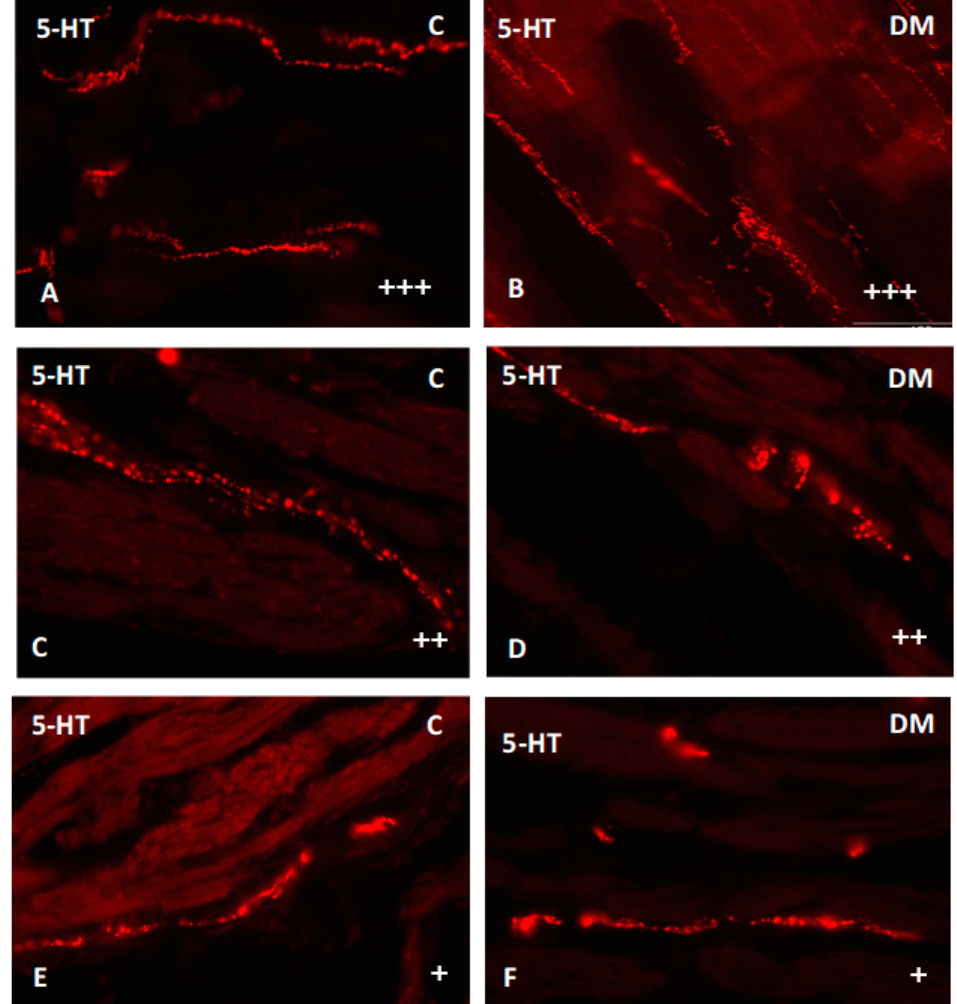
Figure 9. Serotonin-immunoreactive nerve fibers in various parts of mucosal layer in the porcine small intestine. ( A ) The duodenum in control animals (+++); ( B ) the duodenum in experimental group (+++); ( C ) the jejunum in control animals (++); ( D ) the jejunum in experimental group (++); ( E ) the ileum in control animals (+); ( F ) the ileum in experimental group (+). (+)—single nerve fibers; (++)—rare nerve fibers; (+++)—very dense nerve fibers.